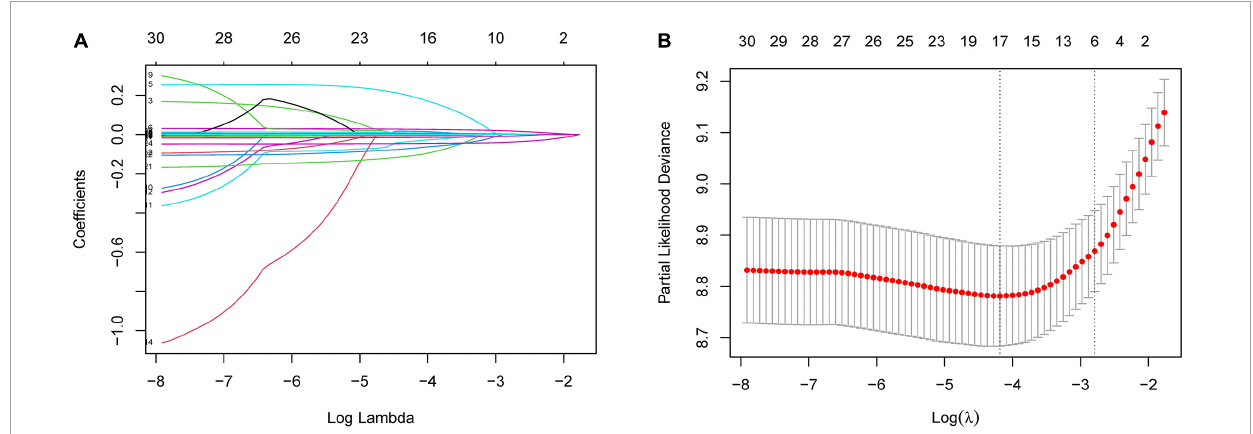
FIGURE2 Risk factors contributing to death within 5 years in patients with IHD were selected using LASSO regression models. (A) LASSO coefficient profiles of the 31 features. A coefficient profile plot was generated against the log(lambda) sequence. (B) Optimal parameter (lambda) selection in the LASSO model used five-fold cross-validation based on minimum criteria. The partial likelihood deviance (binomial deviance) curve was plotted vs. log(lambda). Dotted vertical lines were drawn at the optimal values by using the minimum criteria and the 1 SE of the minimum criteria (the 1-SE criteria). LASSO coefficient profiles of the six features.